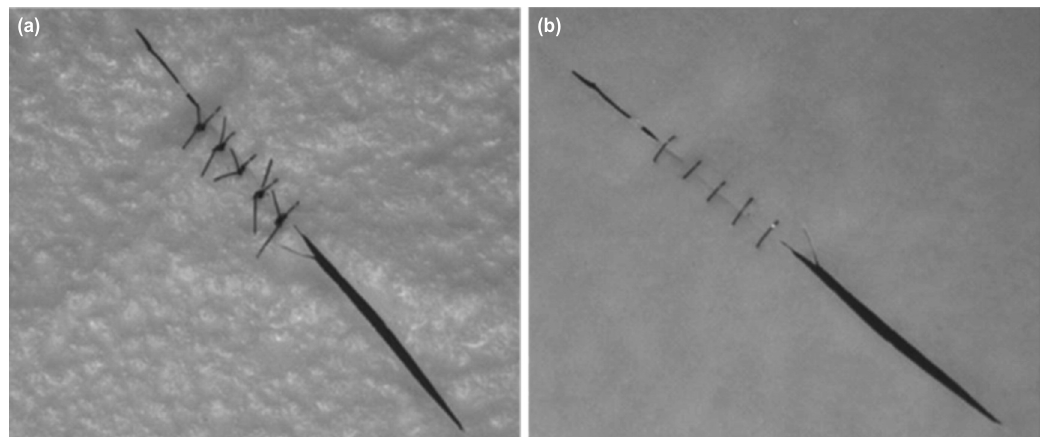
(a) Upper surface of latex sheet showed the 5 knots and (b) Undersurface of the same latex sheet showed parallelity of sutures, Fig. 2: approximation of cut edges of latex sheet, proper suture spacing and placement.